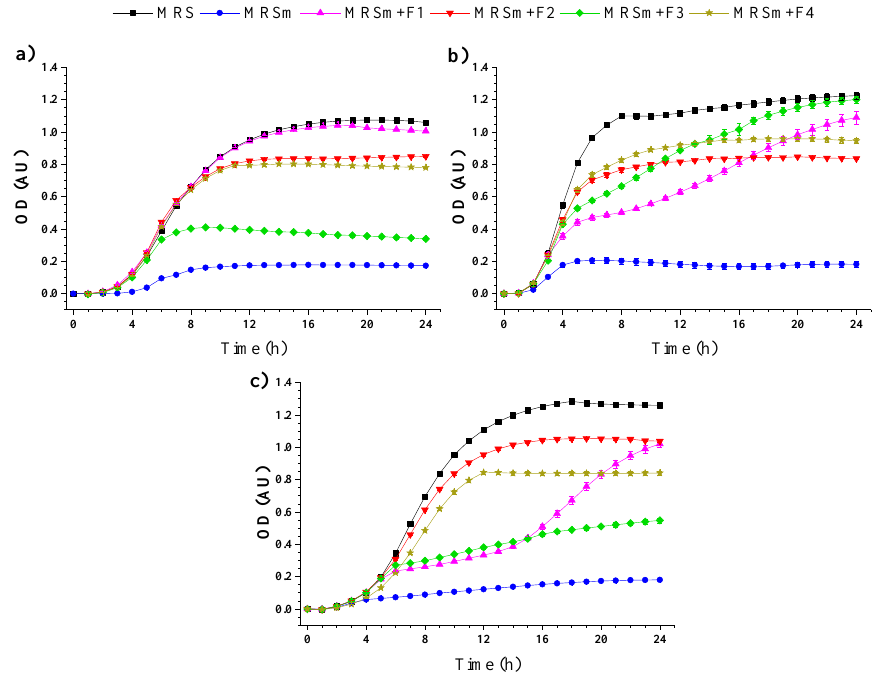
Figure 4. Growth kinetics of ( a ) Lactobacillus plantarum , ( b ) Lactobacillus paracasei , and ( c ) Lactobacillus rhamnosus in MRS medium with glucose (square, MRS), without glucose (circle, MRSm), and replacing glucose as a carbon source with the gel formulations: MRSm + F1 (triangle, control formulation), MRSm + F2 (inverted triangle, 100% agave syrup), MRSm + F3 (rumble, 100% agave fructan), and MRSm + F4 (star, 50% agave syrup and 50% agave fructan).